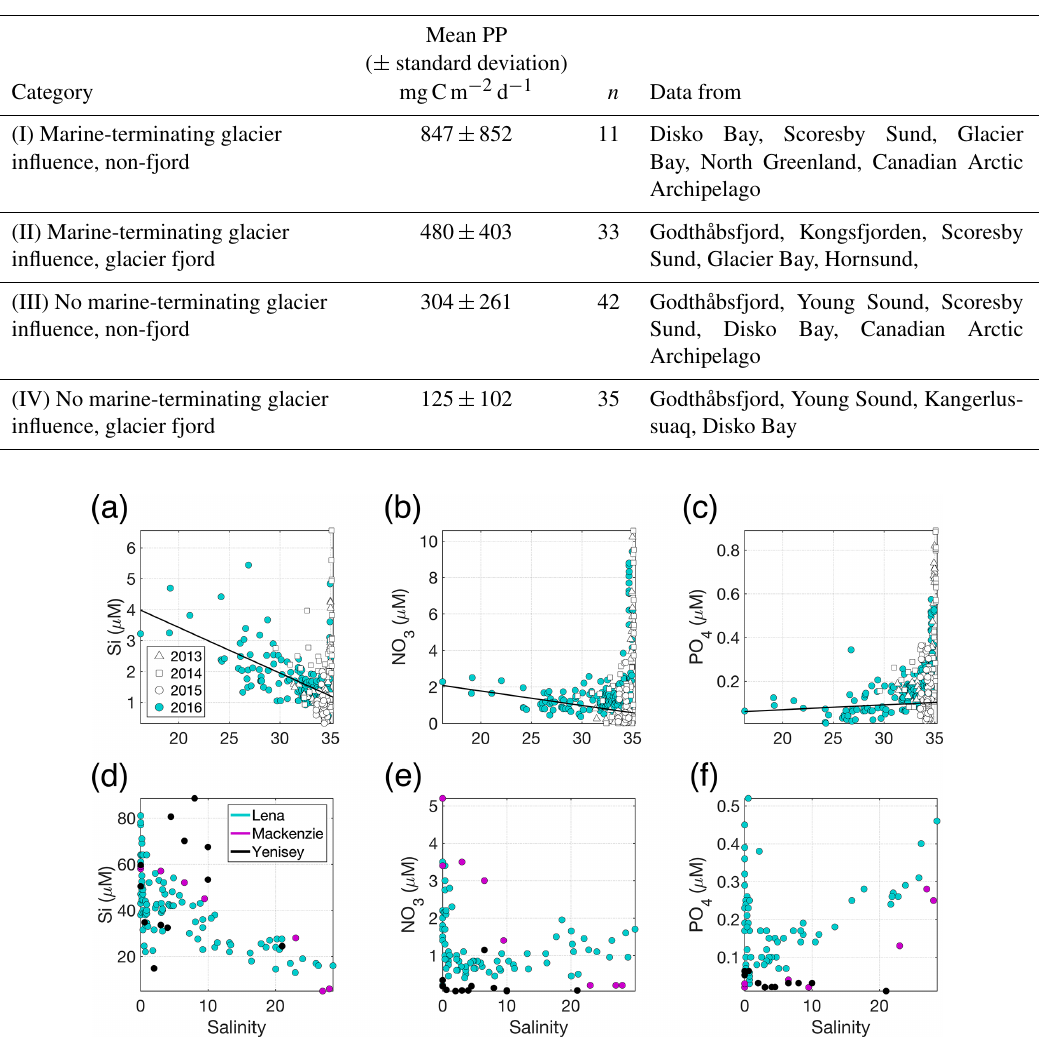
Figure 3. (a) Si, (b) NO 3 and (c) PO 4 distributions across the measured salinity gradient in Kongsfjorden in summer 2013 (Fransson et al., 2016), 2014 (Fransson et al., 2016), 2015 (van de Poll et al., 2018) and 2016 (Cantoni et al., 2019). Full depth data are shown, with a linear regression (black line) for glacially modified waters ( S < 34 . 2) during summer 2016. The position of stations varies between the datasets, with the 2016 data providing the broadest coverage of the inner fjord. Linear regression details are shown in Table S1 in the Supplement. (d) Si, (e) NO 3 and (f) PO 4 distributions in surface waters of three major Arctic river estuaries: the Lena, Mackenzie and Yenisey